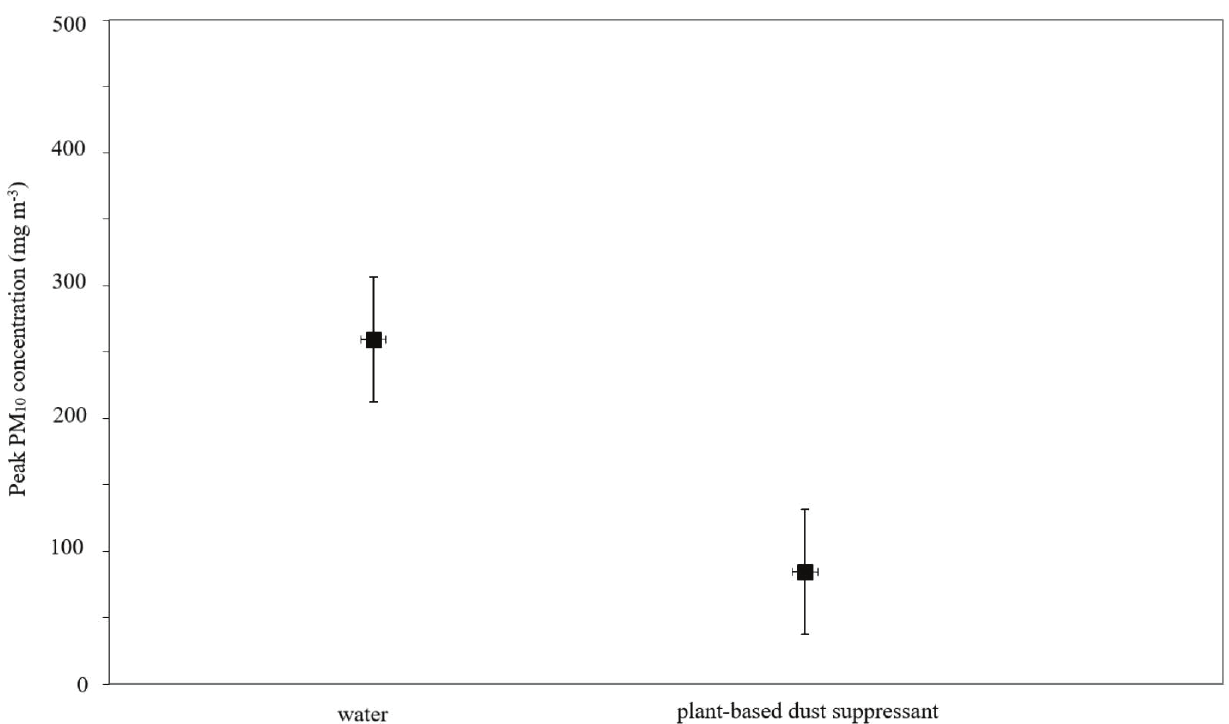
Fig. 6 – Effects of water and dust suppressant formulation on the peak PM